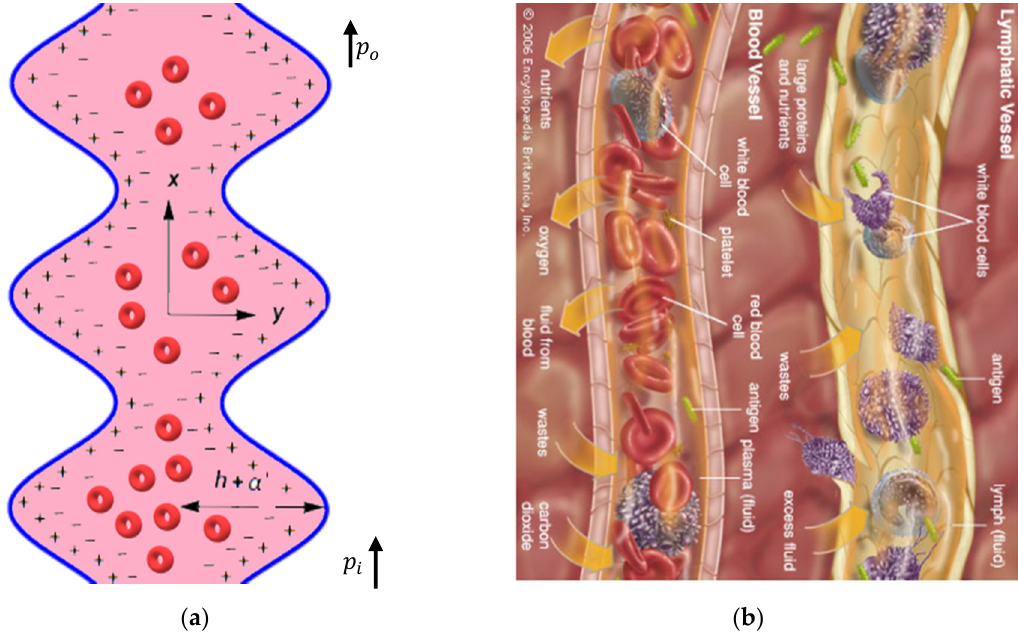
Figure 1. ( a ) Physical modelling of the problem. ( b ) Example for extracellular fluid that contains plasma. The isotropic rheological equation of a Rabinowitsch fluid takes the following form: